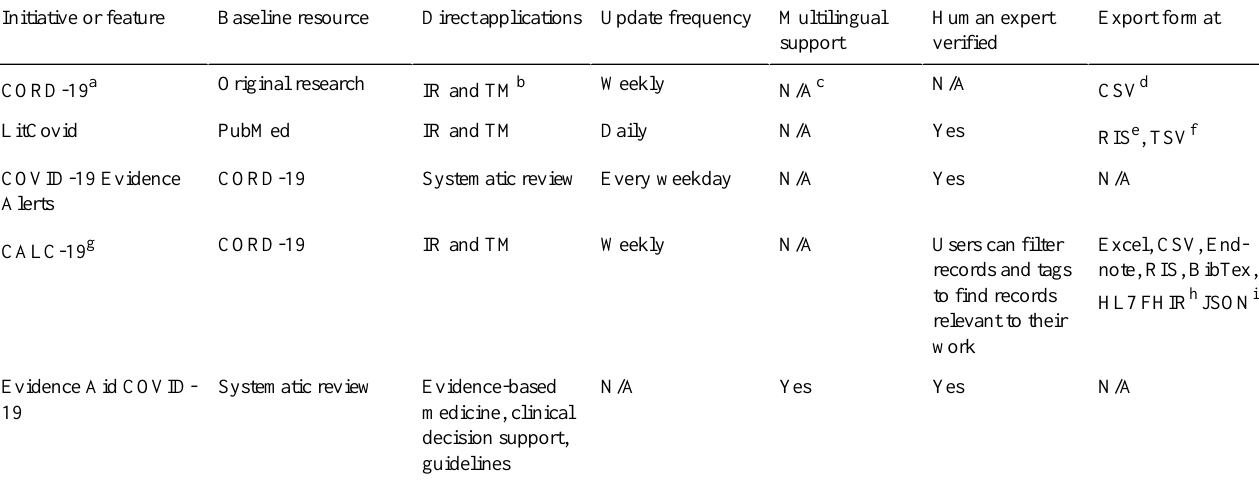
Table 3. Comparative summary of secondary-level resources based on different features that are important for researchers to expand their work on